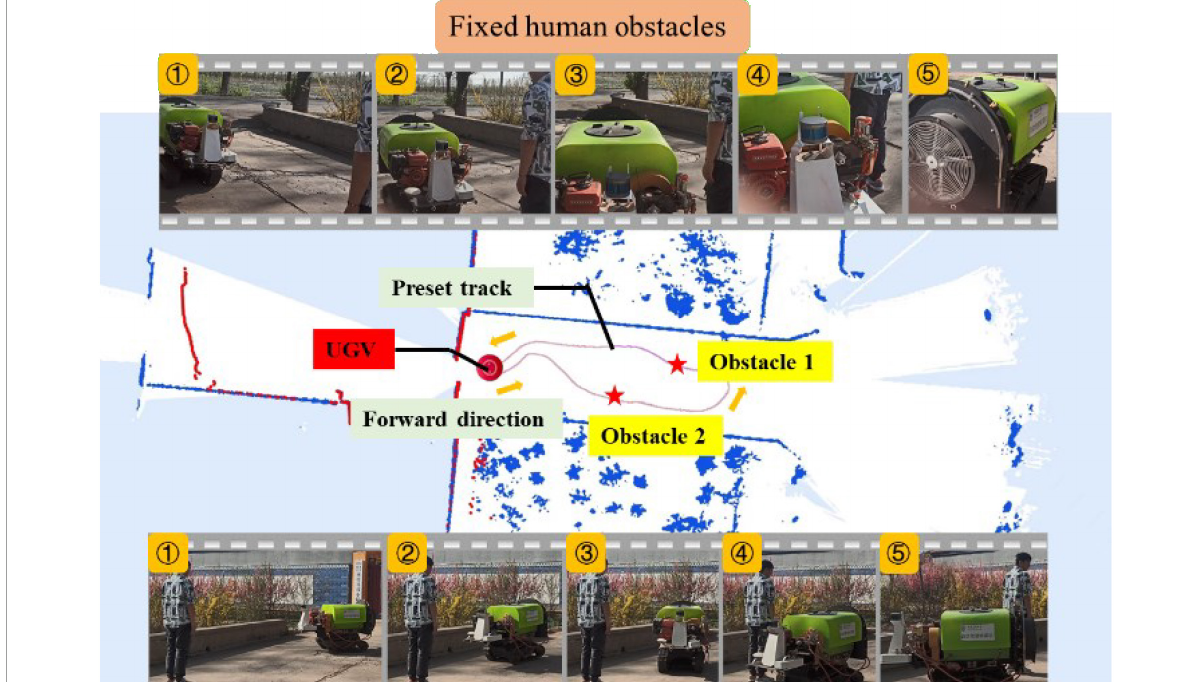
FIGURE13 Experiment of fixed human